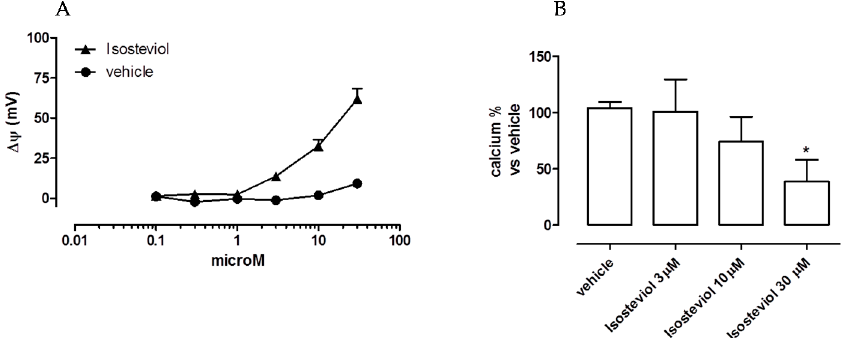
Figure 1. Changes of mitochondrial membrane potential ( A ) and of calcium uptake into mitochondrial matrix ( B ), potentiometrically measured, following addition of isosteviol at cardiac mitochondria suspensions (1 mg/mL). Asterisks indicate significant differences vs. vehicle (* p < 0.05).